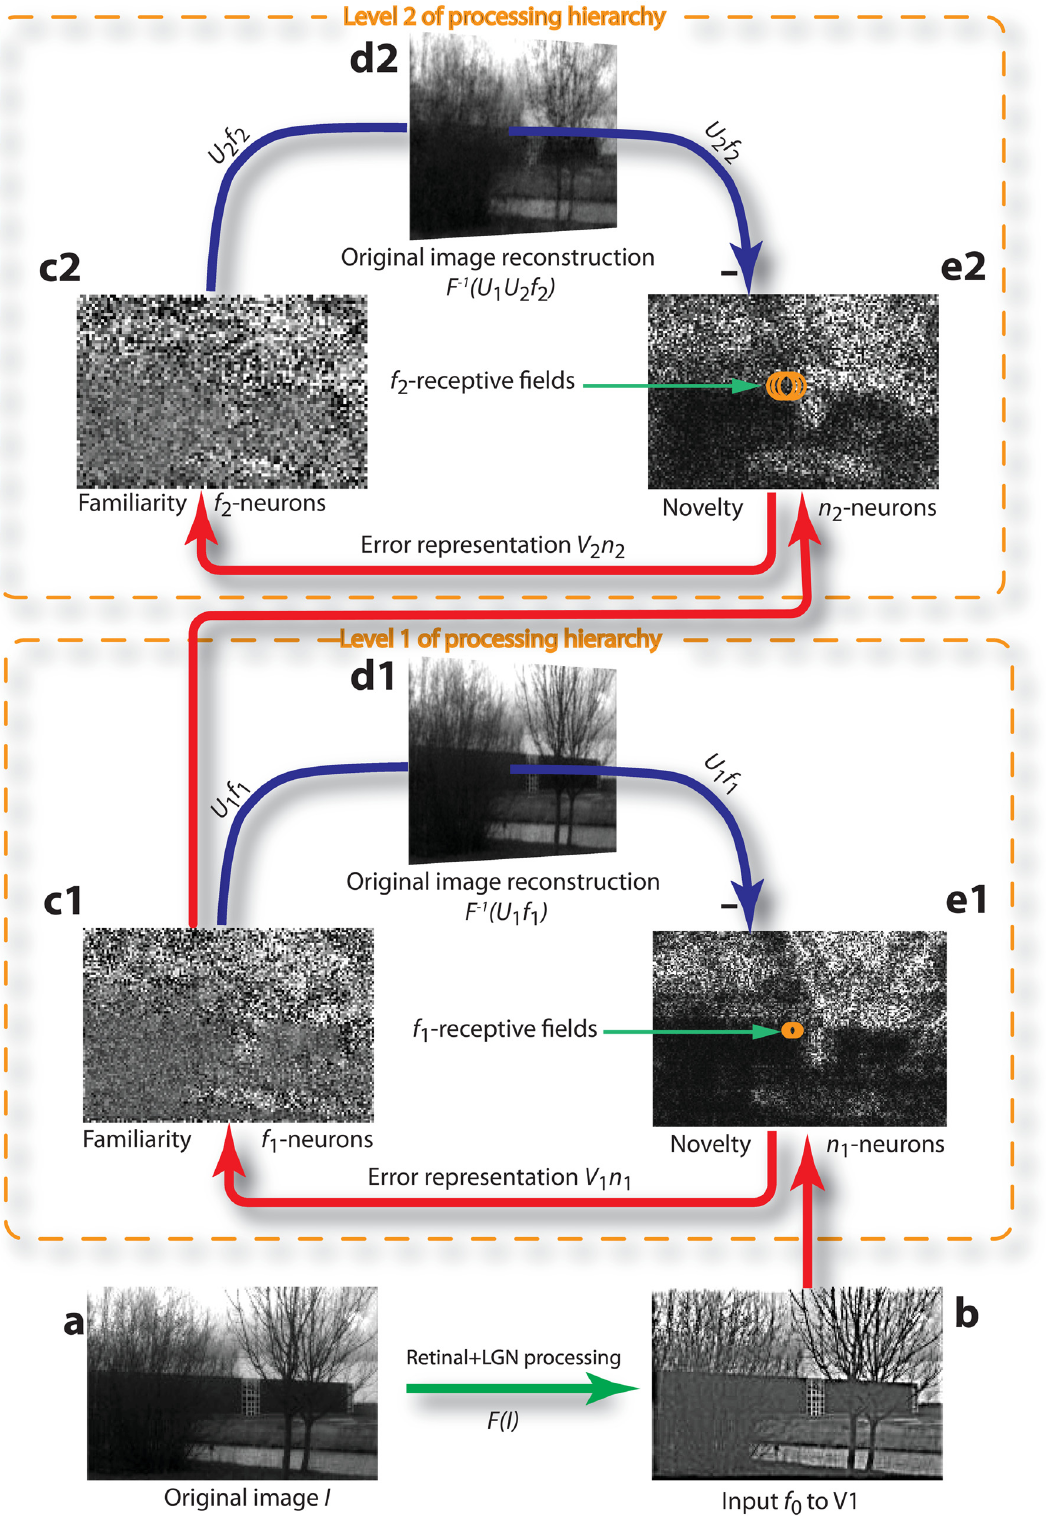
Fig 1. Modular predictive coding and image reconstruction after learning. a Example of a novel image I presented to the network after learning on 1000 other images in a total of 5000 randomly sampled presentations. b Input f 0 to the first level after retinal and LGN processing. c1 Activity of level-1